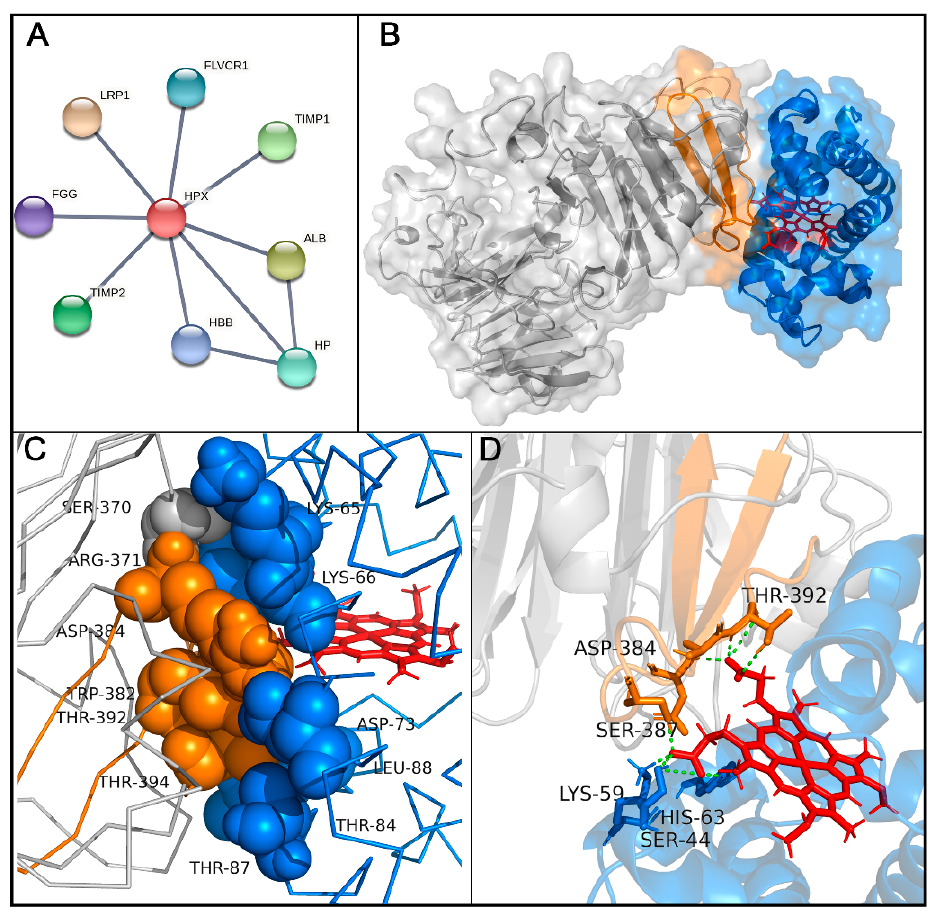
Figure 4. Hemopexin interaction with hemoglobin (Hb) β -chain. ( A ) Network analysis of hemopexin interactome, with Hx interacting with albumin (ALB), haptoglobin (HP), the β -chain of hemoglobin (HBB), the fibrinogen gamma chain (FGG), metalloproteinase inhibitors 1 and 2 (TIMP1 and TIMP2), low-density lipoprotein receptor-related protein 1 (LRP1), and feline leukemia virus subgroup C receptor-related protein 1 (FLVCR1). ( B ) Molecular docking of hemopexin (gray) and active sequence (Hb5; orange) with human hemoglobin β -chain (blue; PDB 2m6z). ( C ) Interaction of hotspot residues between hemoglobin β -chain (blue spheres) and Hx (orange spheres). ( D ) Hydrogen bonds formed by residues in hemoglobin β -chain that interact with heme group (blue sticks and green dashes) and residues in Hx that mediate interaction with heme (orange sticks and green dashes).